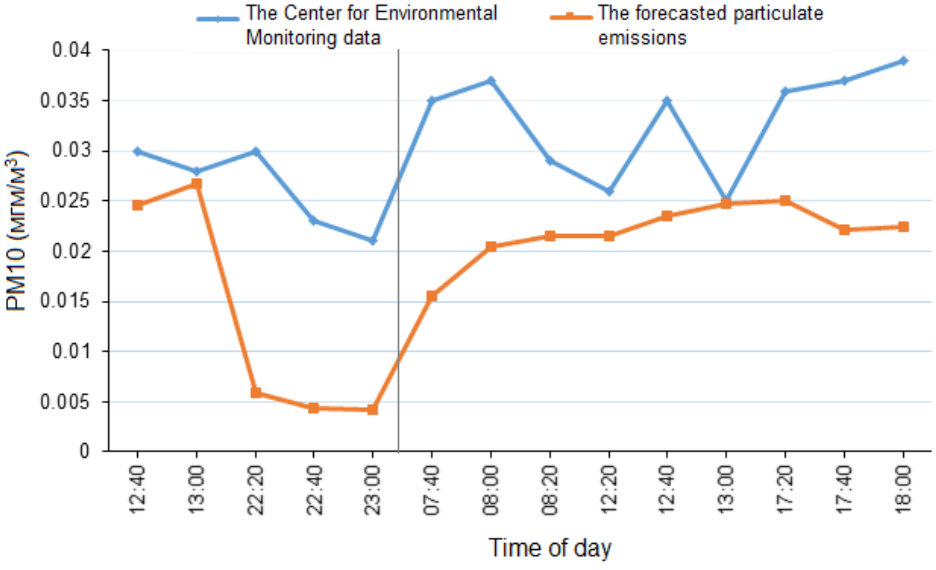
Figure 16. Comparison of the forecasted and actual PM10 emission concentrations.